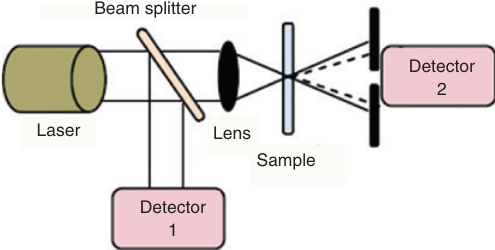
Figure 1: Z-scan experimental setup for the measurement of NLO